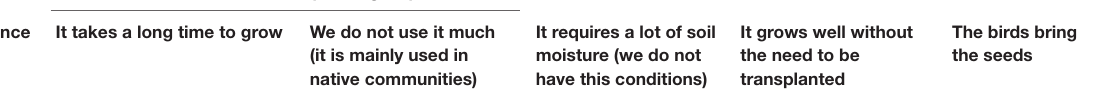
TABLE 5 | Farmers’ motivations for not transplanting a “wild” food plant species in relation to perceived abundance ( n = 12). Motivations for not transplanting a